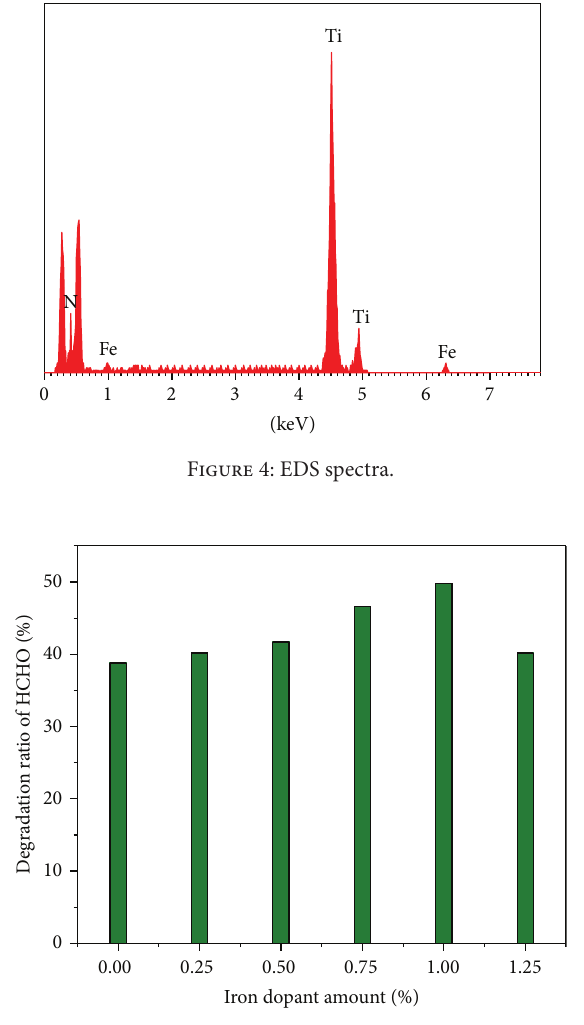
Figure 5: Effect of iron doping amount on photocatalytic activity of Fe-doped TiO 2 .